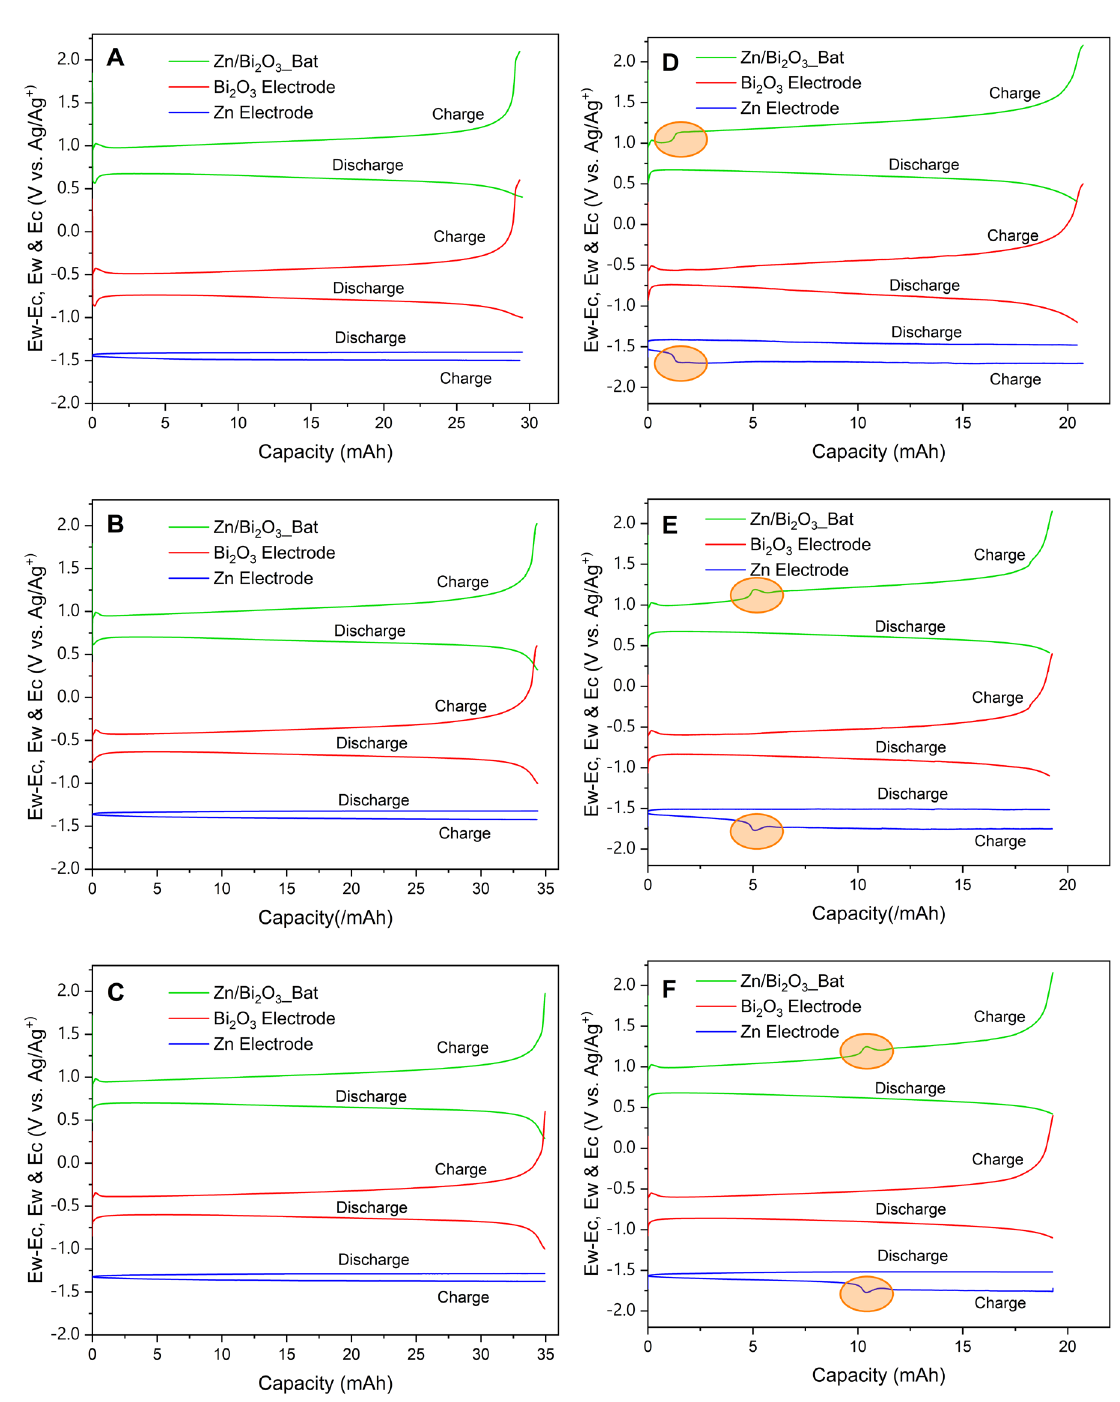
Figure 6. ( A – C ) despite the 3rd, 20th, and 40th Discharge/Charge cycles, respectively, of a Zn/8 M KOH (~50 mL)/Bi 2 O 3 battery. D – F ) show the 3rd, 20th, and 40th Discharge/Charge cycles of a Zn/8 M KOH + 0.1 M ZnO (~50 mL)/Bi 2 O 3 battery. Ew–Ec (red), Ew (green), and Ec (blue) curves are included in all